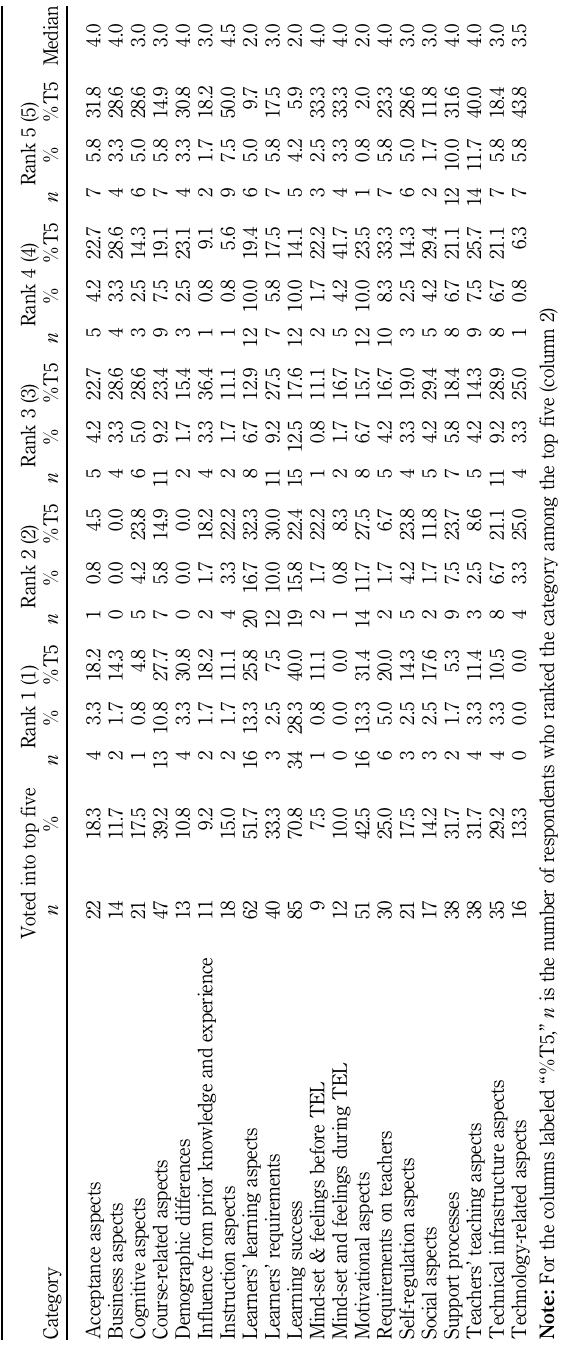
Table V. Frequency